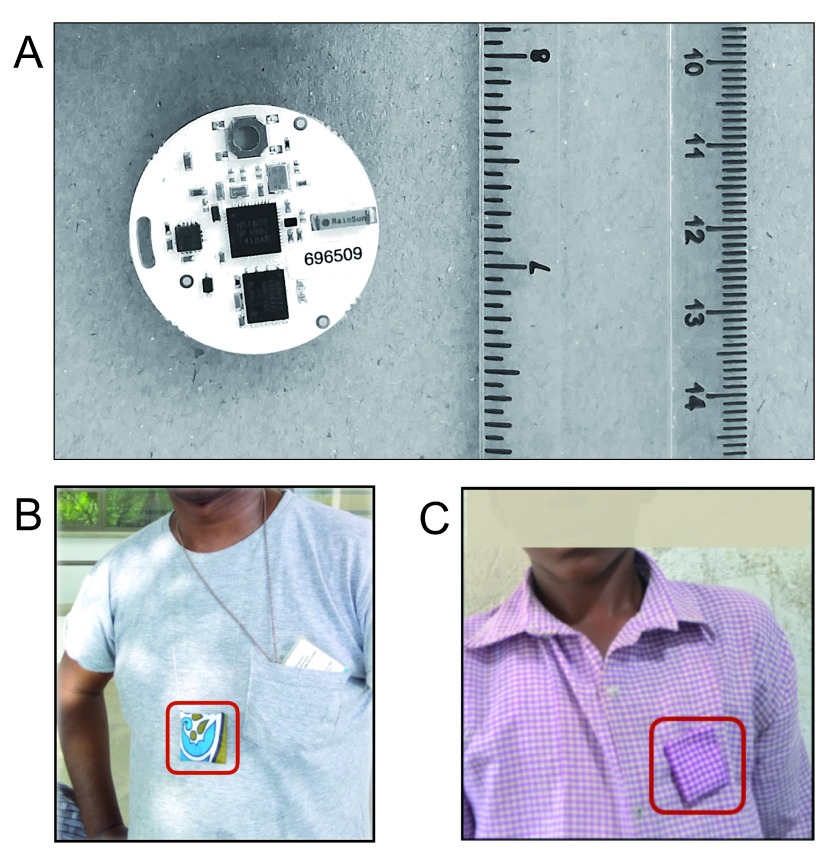
Wireless proximity sensors.(
A) A sensor next to a ruler. (
B) and (
C) How a sensor will be worn by participants, either around the neck with a lanyard or pinned to the shirt pocket, respectively. Household participants will be able to choose the colour of the pouch (
B). Students will have a pouch with colour similar to their school shirt/blouse.